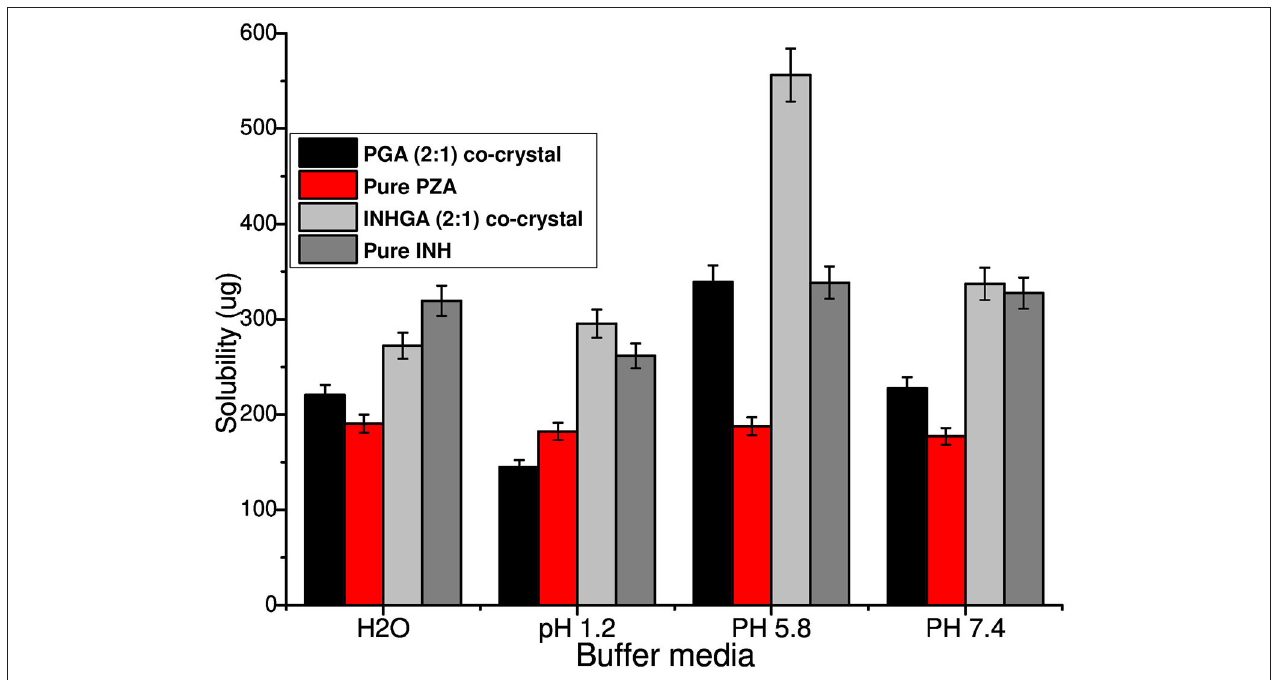
FIGURE 9 | Histogram comparing the solubility of untreated isoniazid (INH) and pyrazinamide (PZA) to their respective co-crystals INHGA (2:1) and PGA